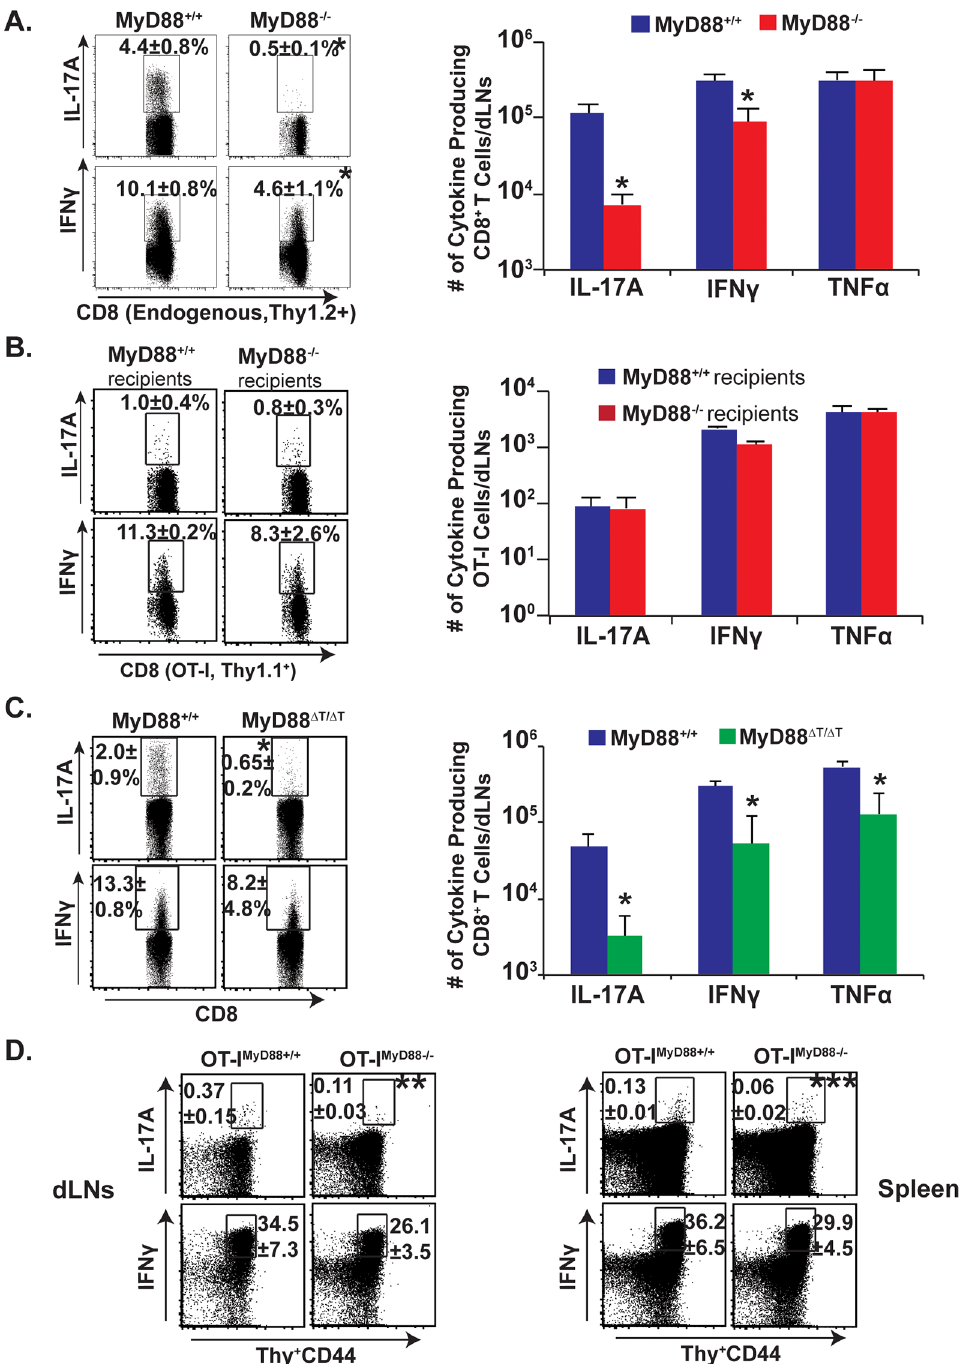
Fig 1. Intrinsic MyD88 signaling regulates Tc17 cell responses. Na ï ve purified OT-I cells (10 6 ) were adoptively transferred into na ï ve congenic wild-type (WT) or MyD88 -/- mice (A & B) . Na ï ve Thy1.1 +ve OT-I wt or OT-I myd88-/- T cells were transferred into na ï ve congenic Thy1.2 +ve WT mice (D) . Mice were CD4 + T cell depleted and vaccinated with OVA-expressing (OT-I) #55 yeast (A, B, D) or #55 yeast ( C ). Draining LNs and spleens were harvested after 2 – 3 weeks to analyze percent and total number of cytokine producing CD8 + CD44 hi T cells by flow cytometry. CD4 + T cells were depleted throughout the experiment. Values are mean ± SD of 4 – 5 mice/group. * P (cid:1) 0.05. Data is representative of 2 – 4 independent experiments.